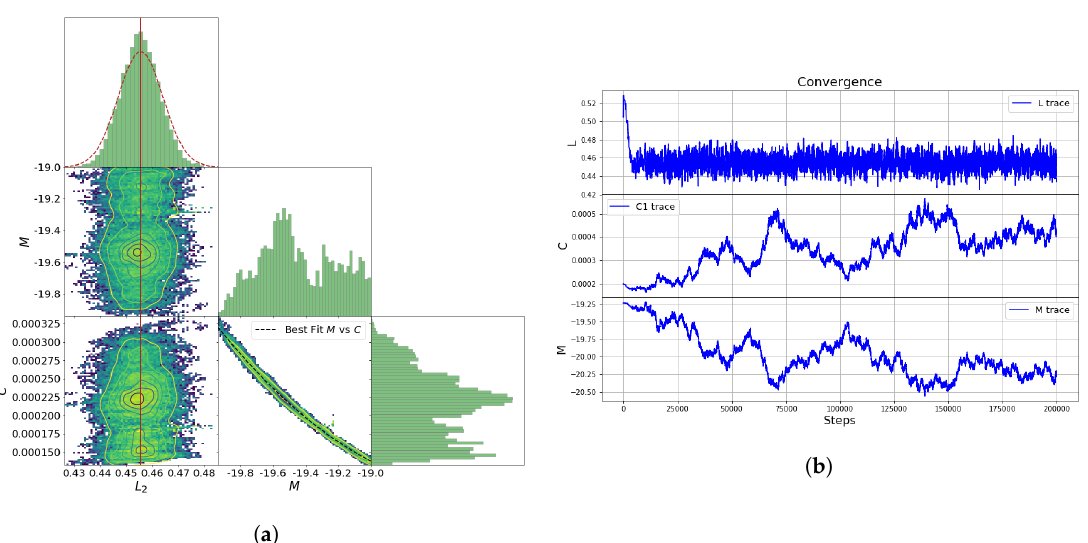
Figure 14. MCMC analysis assuming M as a free parameter in Delta Gravity. ( a ) Posterior probabilities densities. ( b ) Evolution of values with